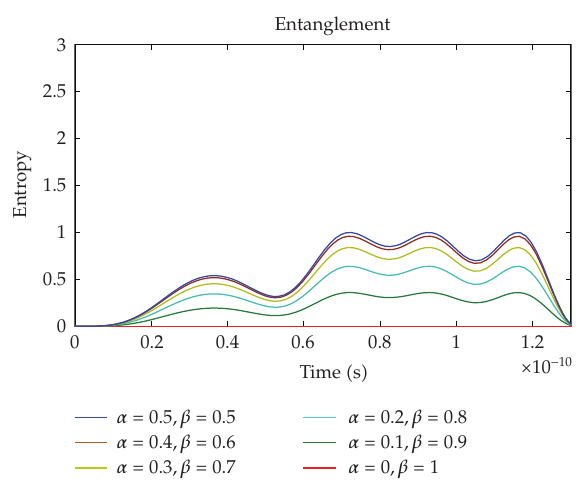
Figure 7: Spin-photon entanglement dynamics for small Δ